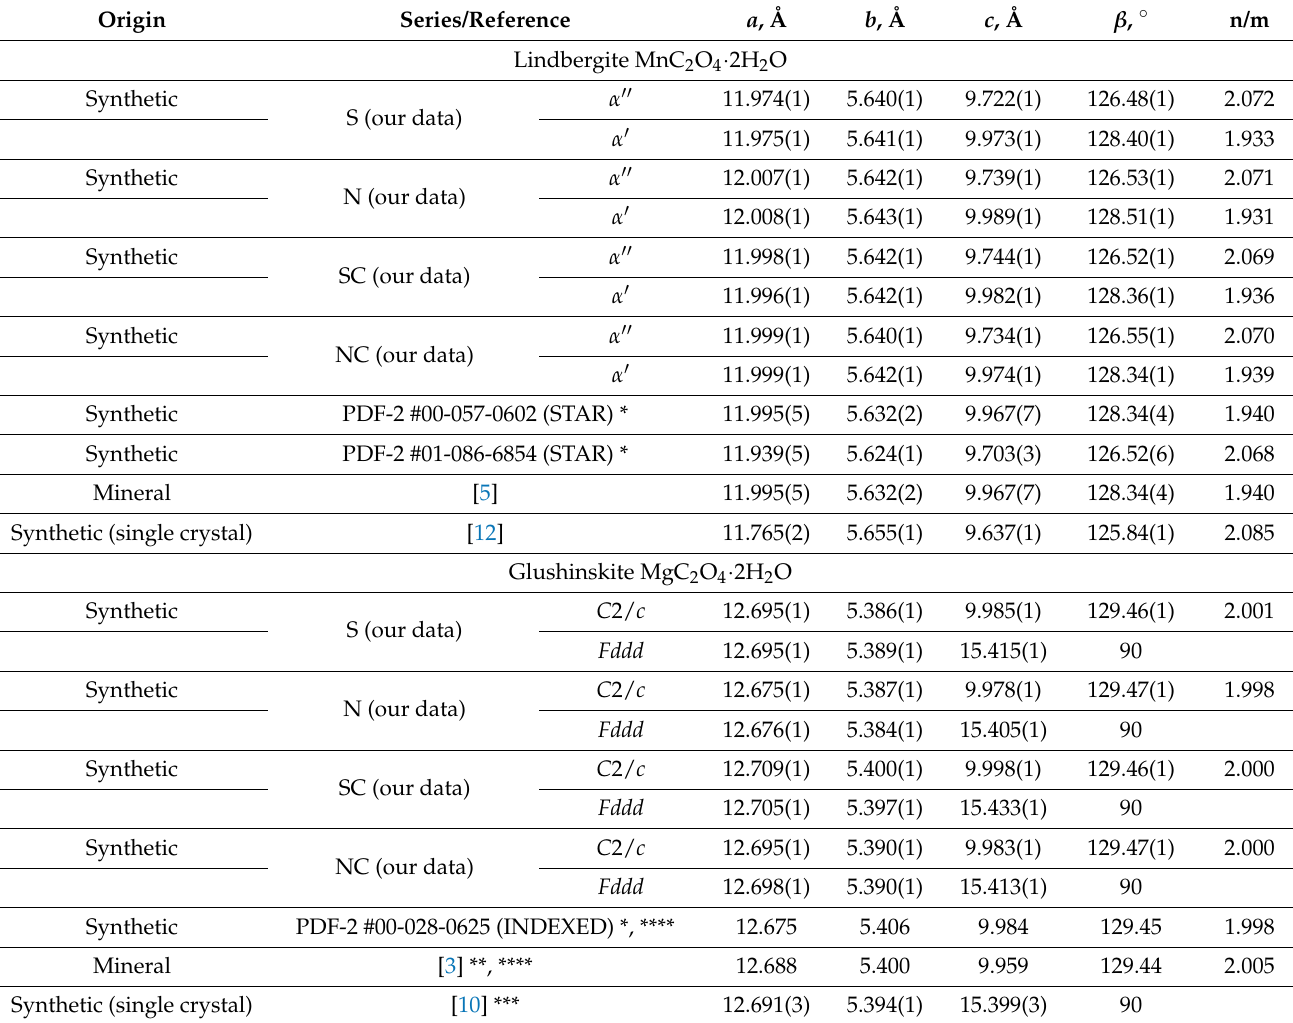
Table 4. Unit cell parameters of synthesized lindbergites (sp. gr. C 2/ c ) and glushinskites (sp. gr. C 2/ c and Fddd ), and their natural